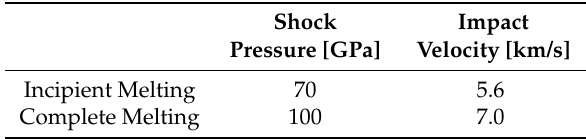
Table 1. Approximate shock-melting properties of aluminum [51].